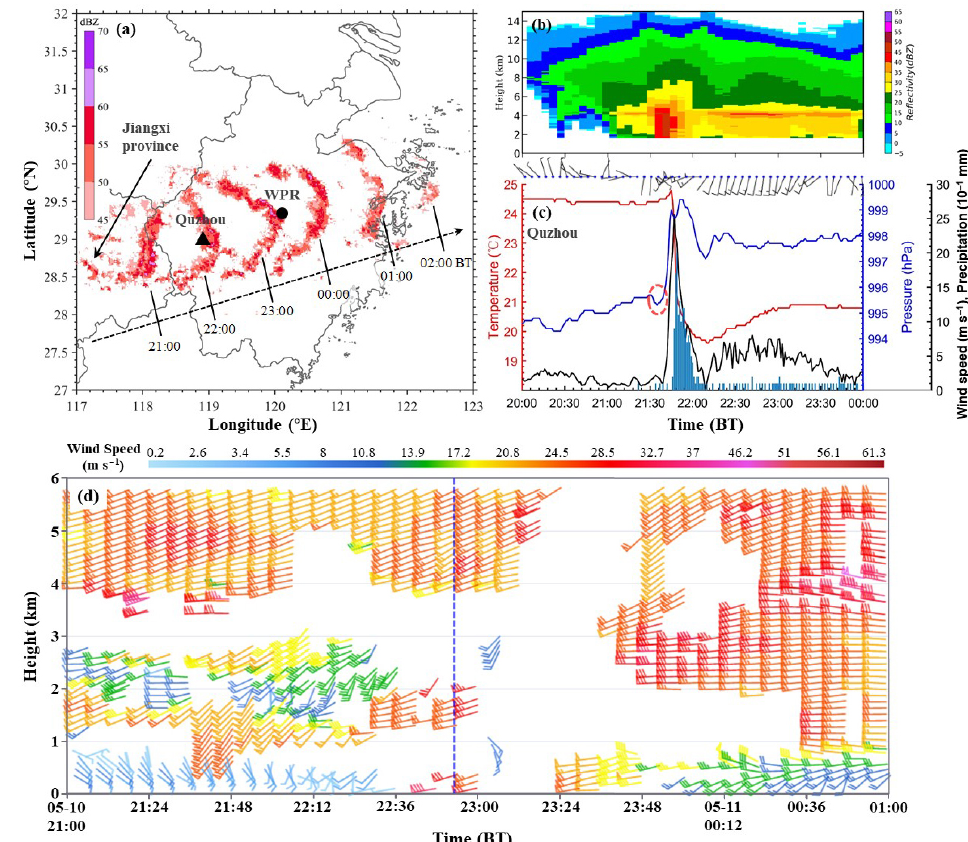
Figure 4. Path and vertical echo structure of the squall line and changes in the surface meteorological elements. ( a ) Evolution of a Z H mosaic of the squall line (>45 dBZ) (the dotted black arrow indicates the approximate direction of movement of the BSL). ( b ) Height–time representation of QVPs of Z H retrieved from the QZ-SPOL data collected at an elevation angle of 19.5° from 2000 BT on 10 May to 0000 BT on 11 May 2021. ( c ) Time series of surface temperature, pressure, wind velocity, and precipitation measurements taken at intervals of 1 min and wind velocity and direction measurements taken at intervals of 5 min at Quzhou station between 2000 BT on 10 May 2021 and 0000 BT on 11 May 2021 (the dotted red oval indicates the passage of the leading edge of the squall line). ( d ) Time series of the ground-relative horizontal wind fields at different heights observed by the WPR in Yiwu between 2100 BT on 10 May 2021 and 0100 BT on 11 May 2021 (the dashed blue line indicates the time when the squall line passed over the WPR).